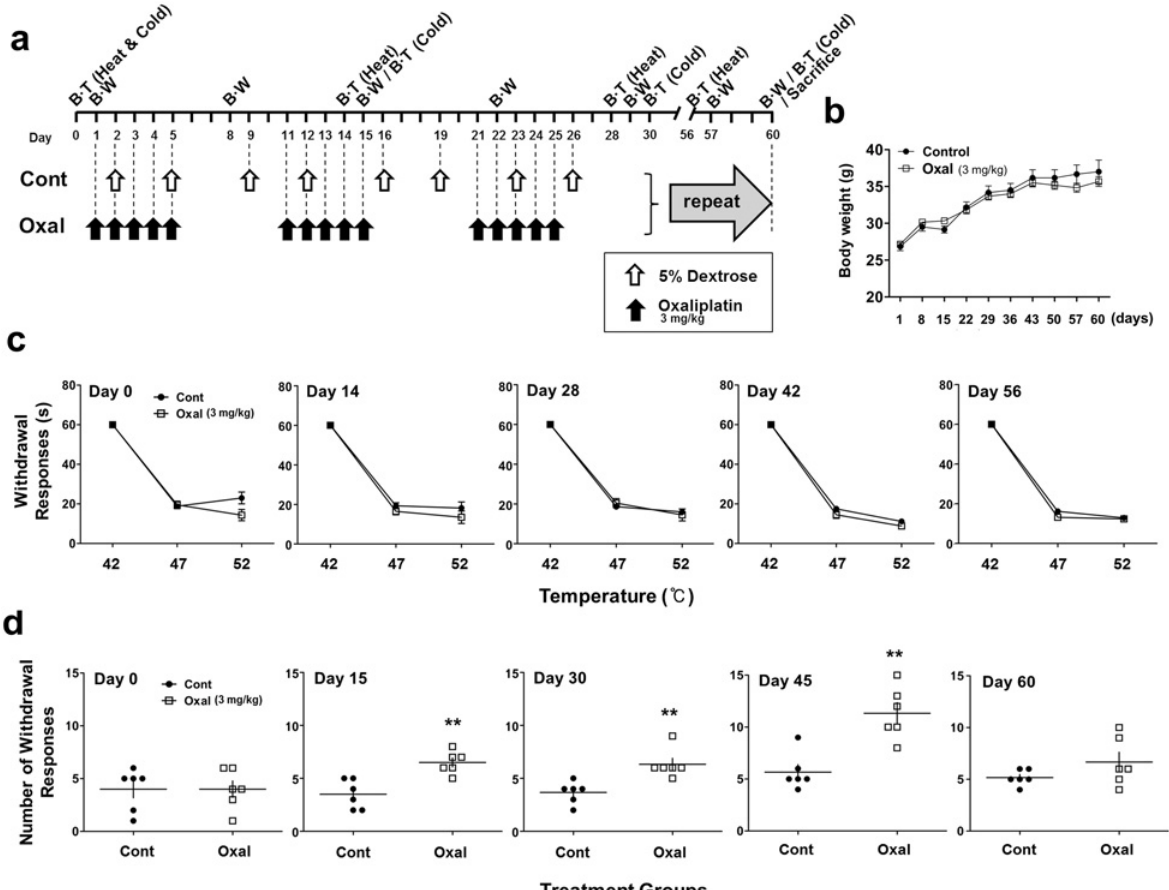
Fig 2. Induction of peripheral neuropathy after long-term exposure to oxaliplatin. 5% dextrose (Cont) and oxaliplatin (3 mg/kg; Oxal) were administered by i.p. injection for 60 days as shown in the schedule (a). Body weight was measured every 7 days from the initial treatment (b). Hot plate test for thermal hyperalgesia was performed before the first infusion and again every 14 days. There were no significant differences between control ( ● ) and drug-treated ( □ : oxaliplatin) mice (c). Acetone test for cold allodynia was performed before the first infusion and again every 15 days. Paw withdrawal responses for cold stimuli showed a sudden decrease on day 60 after a peak on day 45 (d). Results are representative of three independent experiments. Values are expressed as the mean ± SEM ( n = 6 per group). ** p < 0.01 compared with the control group. BT: behavioral test, BW: body